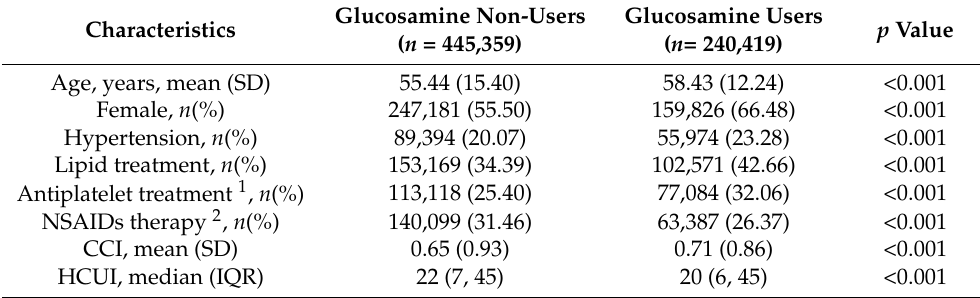
Table 1. Characteristics of the study